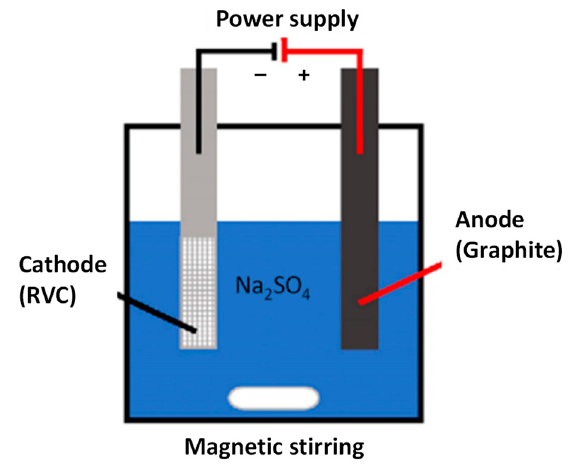
Figure 1. Schematic set up of the electrofenton system.